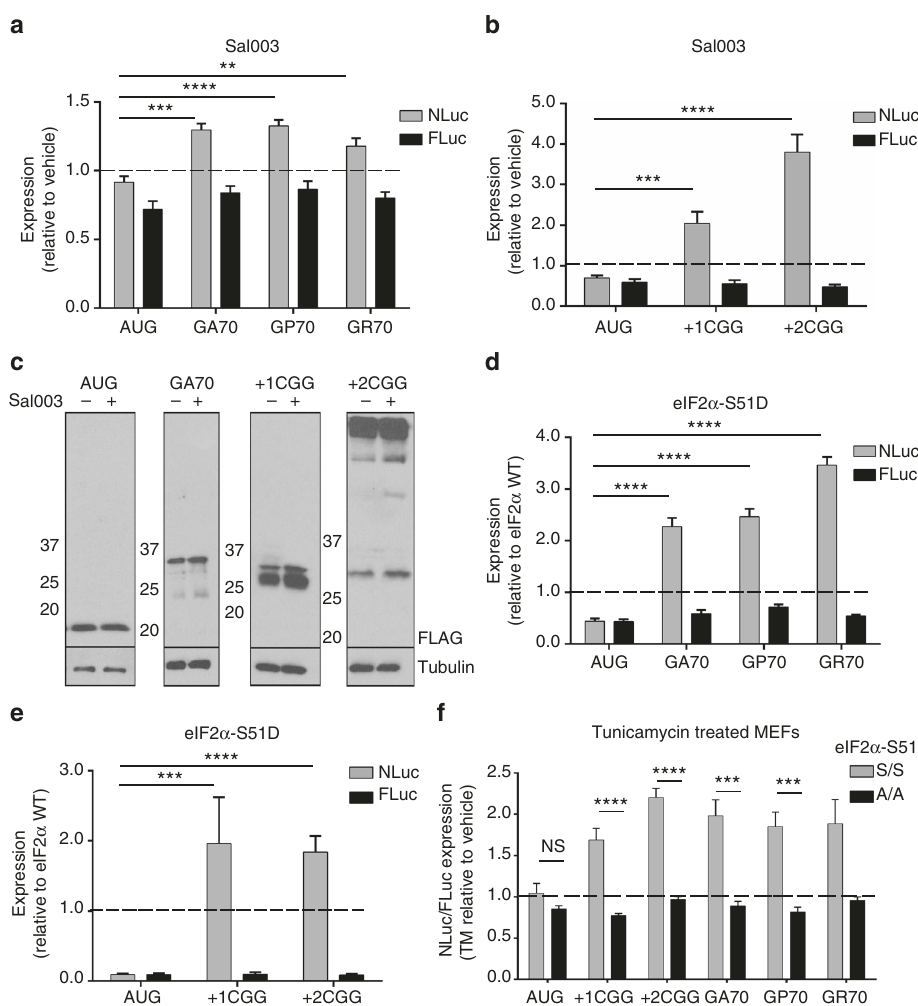
Fig. 4 RAN translation is resistant to eIF2 α phosphorylation. a Expression of control and C9RAN NLuc reporters and co-transfected FLuc in HEK293 cells treated with 40 μ M Sal003, n = 6. b Expression of control and CGG RAN NLuc reporters and co-transfected FLuc in HEK293T cells treated with 20 μ M Sal003, n = 9. c Western blot analysis of control, GA70 RAN and CGG RAN NLuc reporters in HEK293T cells treated with 20 μ M Sal003. d Expression of control and C9RAN NLuc reporters and co-transfected FLuc in HEK293 cells transfected with either WT or S51D (phosphomimetic) eIF2 α , n = 6. e Expression of control and CGG RAN NLuc reporters and co-transfected FLuc in HEK293T cells transfected with either WT or S51D (phosphomimetic) eIF2 α , n = 9 – 15. f Expression of control, CGG, and C9RAN NLuc reporters normalized to co-transfected FLuc in WT eIF2 α -S51 (S/S) and non- phosphorylatable homozygous eIF2 α -S51 A/A mutant mouse embryonic fi broblasts (MEFs) following treatment with 1 μ g mL − 1 tunicamycin (TM), n = 6 – 9. Graphs represent mean ± SEM. Two-tailed Student ’ s t test with Bonferroni and Welch ’ s correction, ∗∗ p < 0.01; ∗∗∗ p < 0.001; ∗∗∗∗ p <